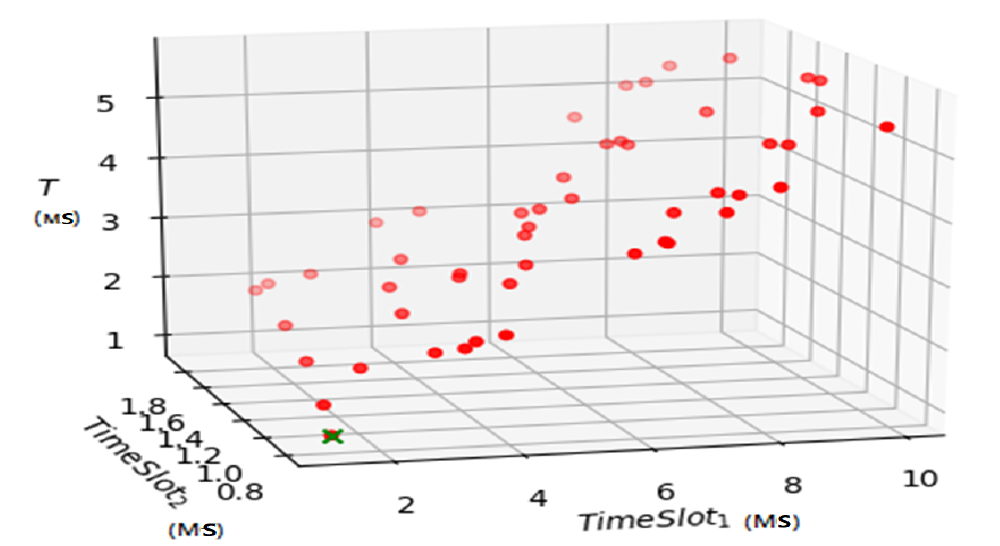
Figure 13. Result of PSO modeling.